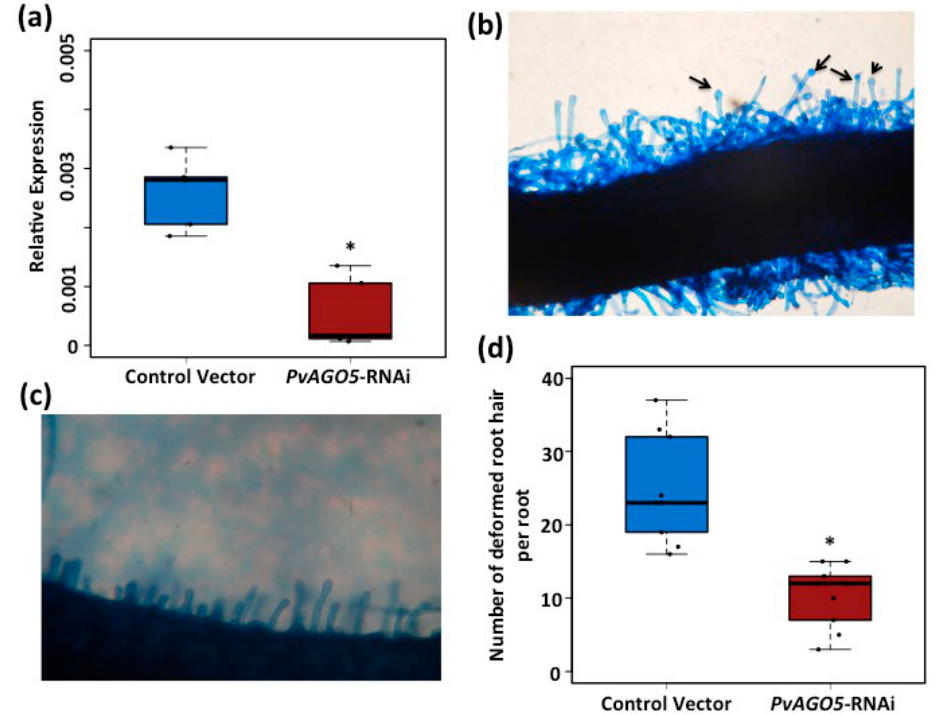
Figure 2. Down-regulation of PvAGO5 reduces the rhizobia-induced root hair deformation in common bean. ( a ) PvAGO5 expression levels in transgenic roots expressing a control vector or the PvAGO5 -RNAi construct. Data shown was obtained from five independent biological replicates, each one containing roots from four different composite plants; ( b ) Rhizobia-induced root hair deformation in common bean transgenic roots expressing a control vector or ( c ) the PvAGO5 -RNAi, black arrows indicate characteristic rhizobia-induced root hair deformation; ( d ) Number of rhizobia-induced root hairs observed in control transgenic roots and PvAGO5 -silenced roots. One-way ANOVA followed by a Tukey HSD test was performed. Asterisk indicates a significant difference ( p -value < 0.01).